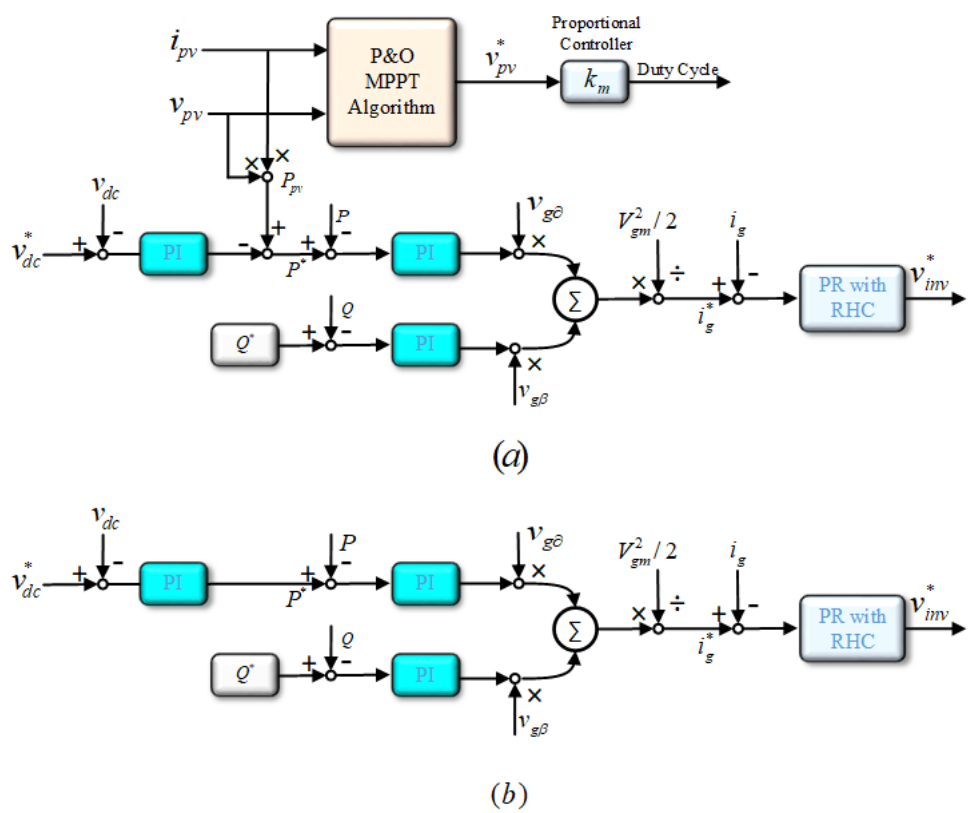
Figure 2. Design of control loop ( a ) with and ( b ) without feedforward power of PV,